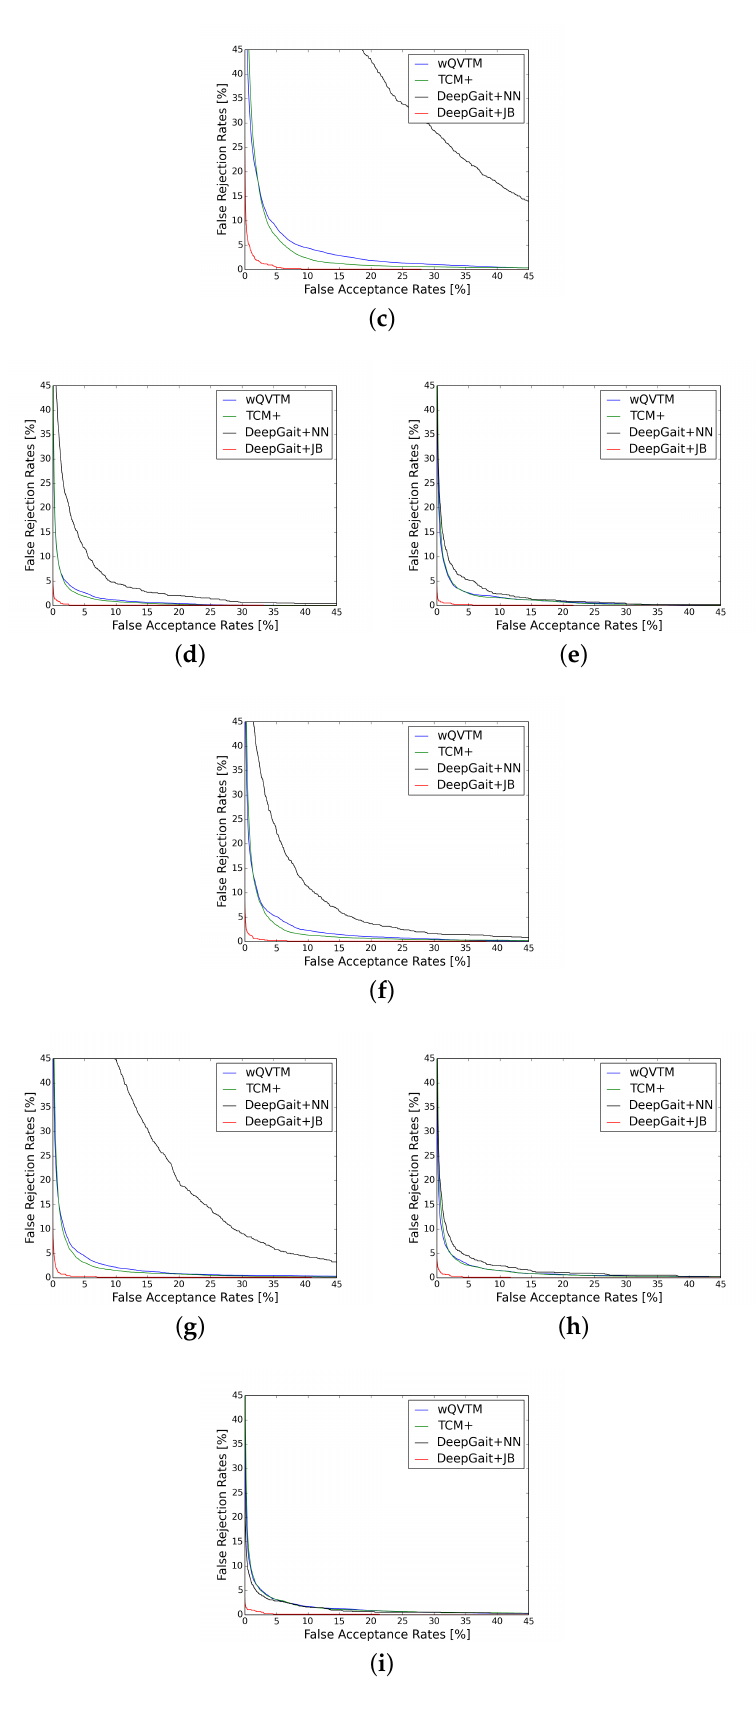
Figure 5. Receiver Operative Characteristics (ROC) curves under different cross-view